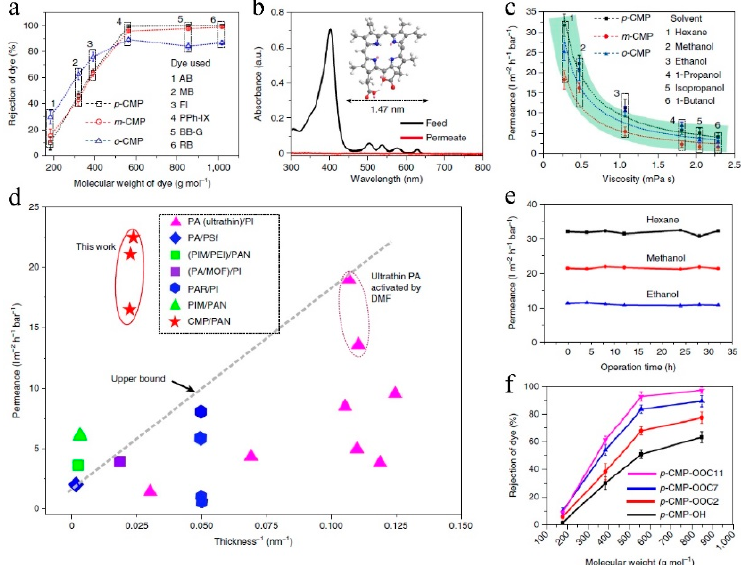
Figure 19. Nanofiltration performances of p-CMP, m-CMP, and o-CMP membranes. ( a ) Rejection behavior of different CMP membranes versus the molecular weight of various dyes (rose bengal (RB, 1,017 g/mol), brilliant blue G (BB-G, 854 g/mol), PPh-IX (562 g/mol), fluorescein-4-isothiocyanate (FI, 389 g/mol), methylene blue (MB, 320 g/mol), and azobenzene (AB, 188 g/mol)) in ethanol. ( b ) Ultraviolet visible absorption spectra of PPh-IX dye in methanol to evaluate the separation performance of the p-CMP membrane. Inset: molecular structure of PPh-IX (C, grey, H, white, N, blue, O, red, lonepair electrons, pink). ( c ) Plot of solvent permeance through different CMP membranes against the solvent viscosity. The dashed curves show the reciprocal fitting of the permeance through p-CMP (black), m-CMP (red), and o-CMP (blue). The green shading shows an inverse relationship between permeance and viscosity. ( d ) Permeance for methanol versus the reciprocal membrane thickness for p-CMP, m-CMP, and o-CMP. Previously reported polymer-based OSN membranes are included for comparison and consist of polyamide (PA), PIM, MOF, and polyarylate (PAR), polyimide (PI), polysulfone (PSf), polyetherimide (PEI), and N , N ′ - dimethylformamide (DMF). The name of each membrane refers to its separating layer on the left and supports the substrate on the right. In two cases, the separating layer is a hybrid material: (PIM/PEI) and (PA/MOF). The dashed line shows the upper bond of the solvent permeability (permeance per unit thickness). ( e ) Plot of hexane, methanol, and ethanol permeances with time for p-CMP membranes. ( f ) Rejection behavior of post-modified p-CMP-OH membranes by different moieties. All nanofiltration experiments were conducted in a dead-end cell at 25 °C under 1 bar. The error bars in ( a , c , f ) represent the standard deviation, which was calculated based on an average of three membranes. Reproduced from Reference [88]. 7.2. Pervaporation The use of the microporous polymer membranes in pervaporation has already been studied such as in the use of the PTMSP membrane for the pervaporative separation of an ethanol/water solution or a butanol solution [100,101]. Both high selectivity and high flux can be obtained due to the high free volume in the membrane. The first separation application of PIMs was in the pervaporative removal of phenol from an aqueous solution [9]. Separation factors of 16–18 were obtained at temperatures of 50 to 80 °C and a phenol feed concentration in the range of 1 to 5 wt%, which indicated the hydrophobic character of the polymer. Although the separation performance was similar to that obtained by a poly(dimethylsiloxane) (PDMS) membrane, these results were obtained by a membrane without optimization. Thus, it was thought that higher selectivities would be achievable through chemical and structural modification without sacrificing the high fluxes. Adymkanov et al. [102] systematically investigated the pervaporation of aliphatic alcohols, water,